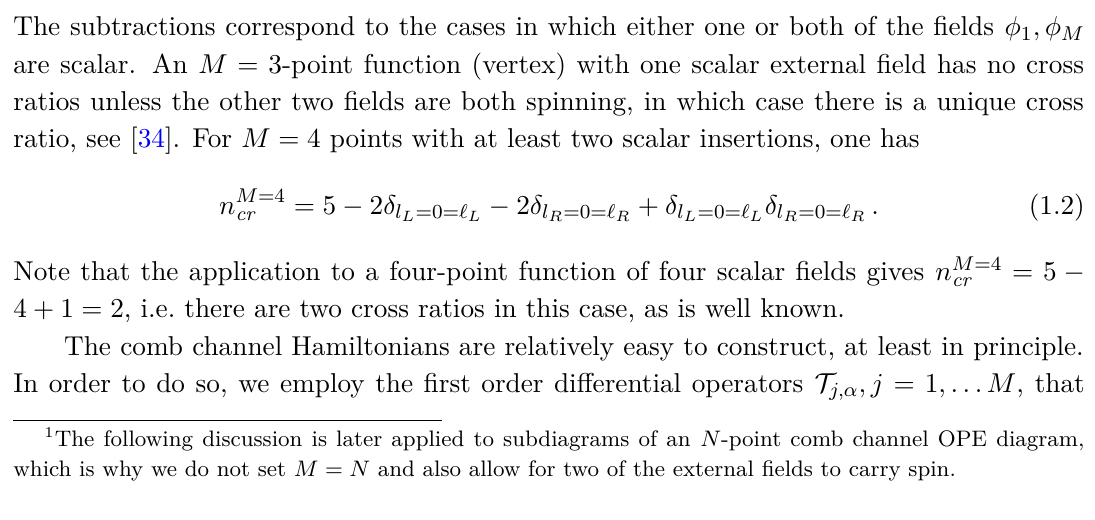
Figure 1 : Schematic representation of an M -point comb channel OPE diagram in d = 4 . All the external legs at the interior of the comb are scalars, while we allow fields φ φ to sit in a generic M